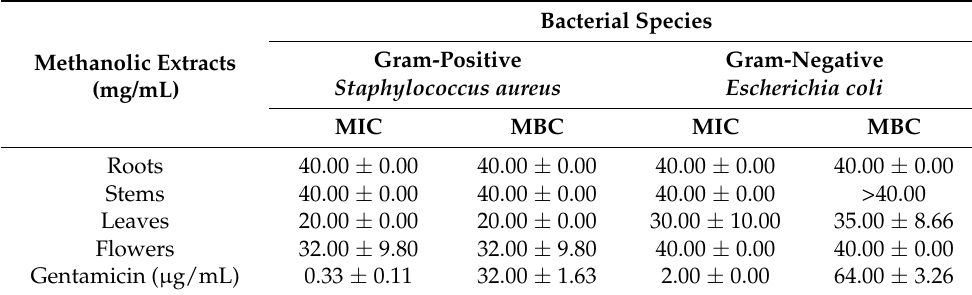
Table 10. MIC and MBC values of methanolic extracts of Cladanthus mixtus and a reference antibi- otic agent.